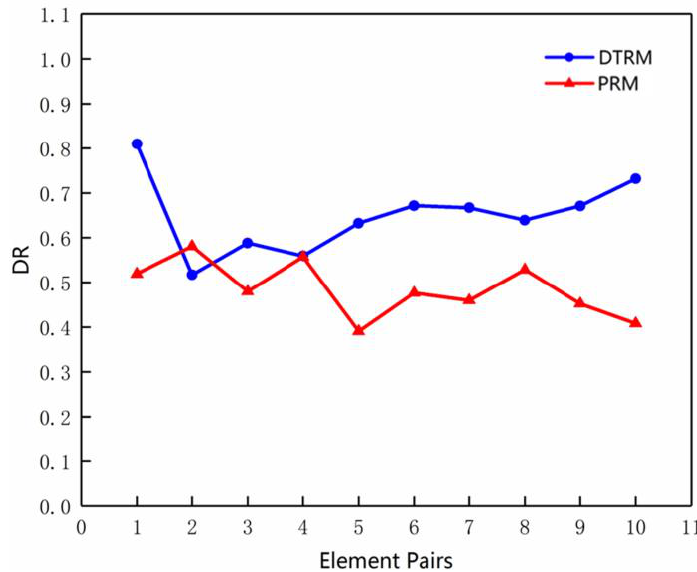
Figure 20. DR of DTRM and PRM.